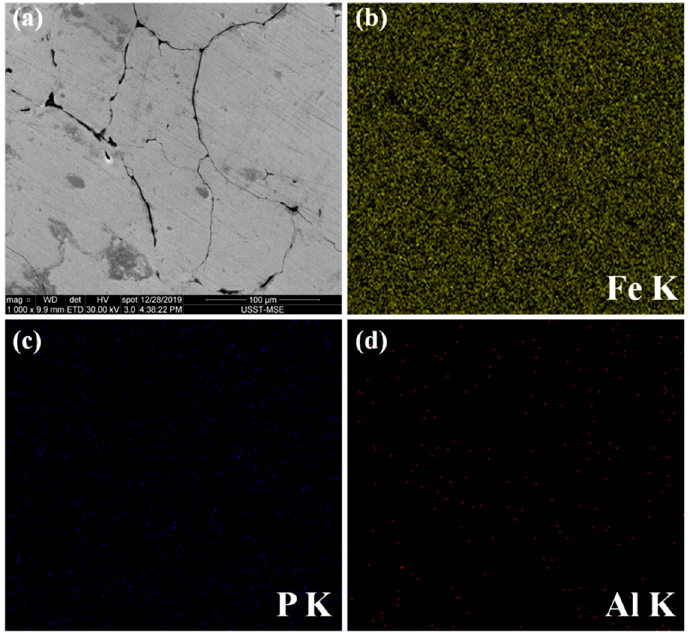
Figure 6. SEM images of ( a ) the polished surface of Fe @ phosphate @ Al 2 O 3 SMC compact and EDS maps of ( b ) iron, ( c ) phosphorus and ( d ) aluminum.